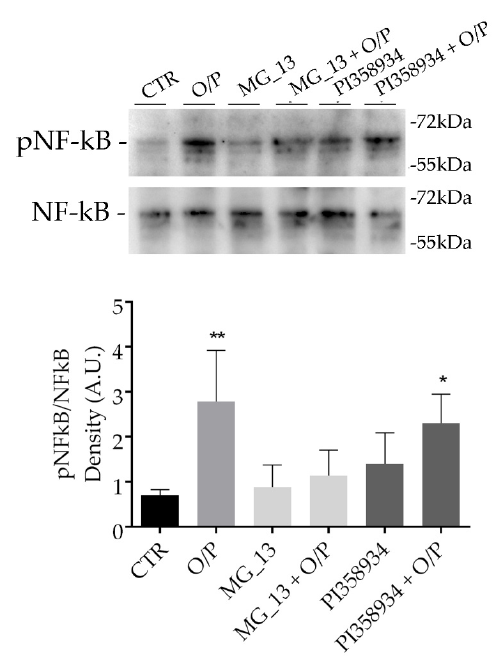
Figure 4. E ff ects of the chickpea extracts on nuclear factor kappa beta (NF-kB) phosphorylation. FaO cells were treated as described in the Methods Section. An equal amount of proteins (30 µ g / lane) was separated by gel electrophoresis and immunoblotted for evaluation of pNF-kB and total NF-kB levels. Densitometric analysis revealed that the O / P treatment caused a significant increase in pNF-kB levels as compared with cells under basal condition (CTR). Treatment with MG_13 (0.1 mg / mL) prevented the O / P-dependent increase of pNF-kB. In contrast, treatment with PI358934 (0.1 mg / mL) did not impair the O / P-action. No significant alterations in pNF-kB levels were observed by the sole treatment with chickpea extract. Data are expressed as means ± S.D. and were analyzed by one-way ANOVA followed